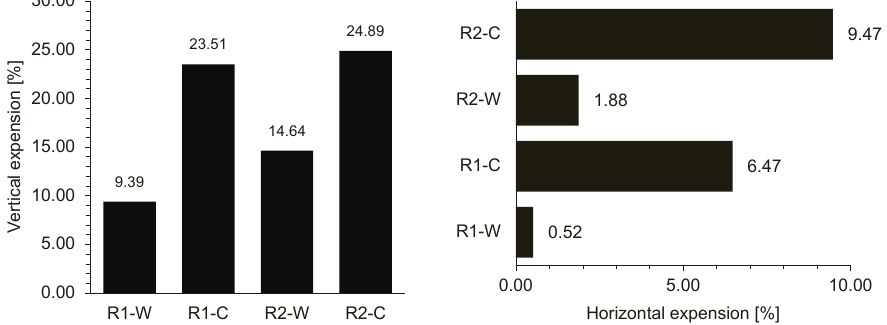
Figure 2. Vertical and horizontal expansion of the samples.